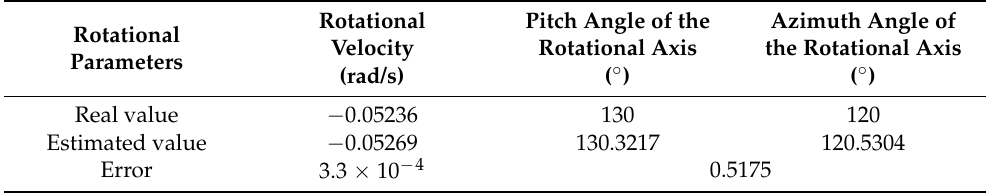
Table 5. Estimated result of rotational parameters of Tiangong-1.